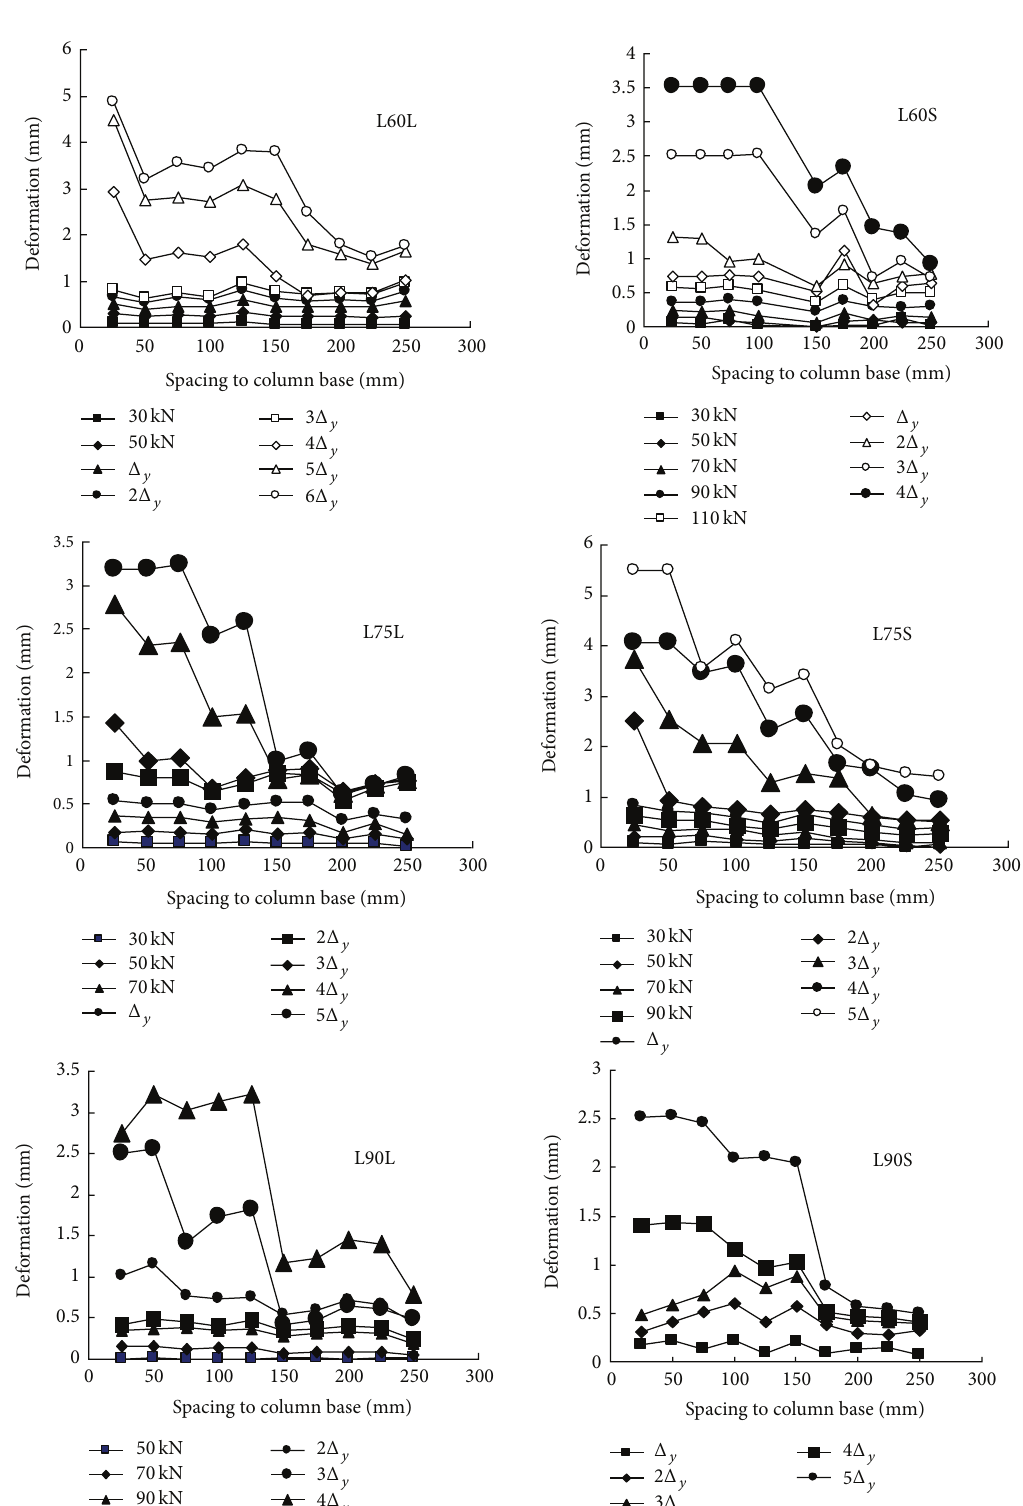
Figure 7: Deformation of border fiber at the bottom of L-shaped